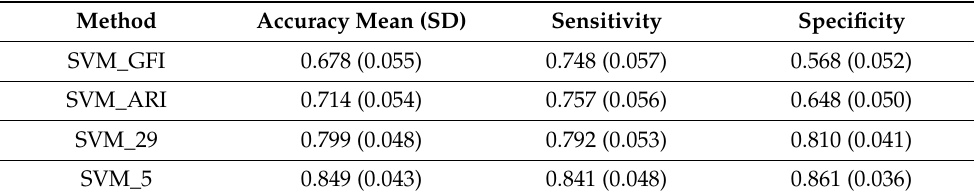
Table 4. Validation performance of SVM with different feature sets on testing data.